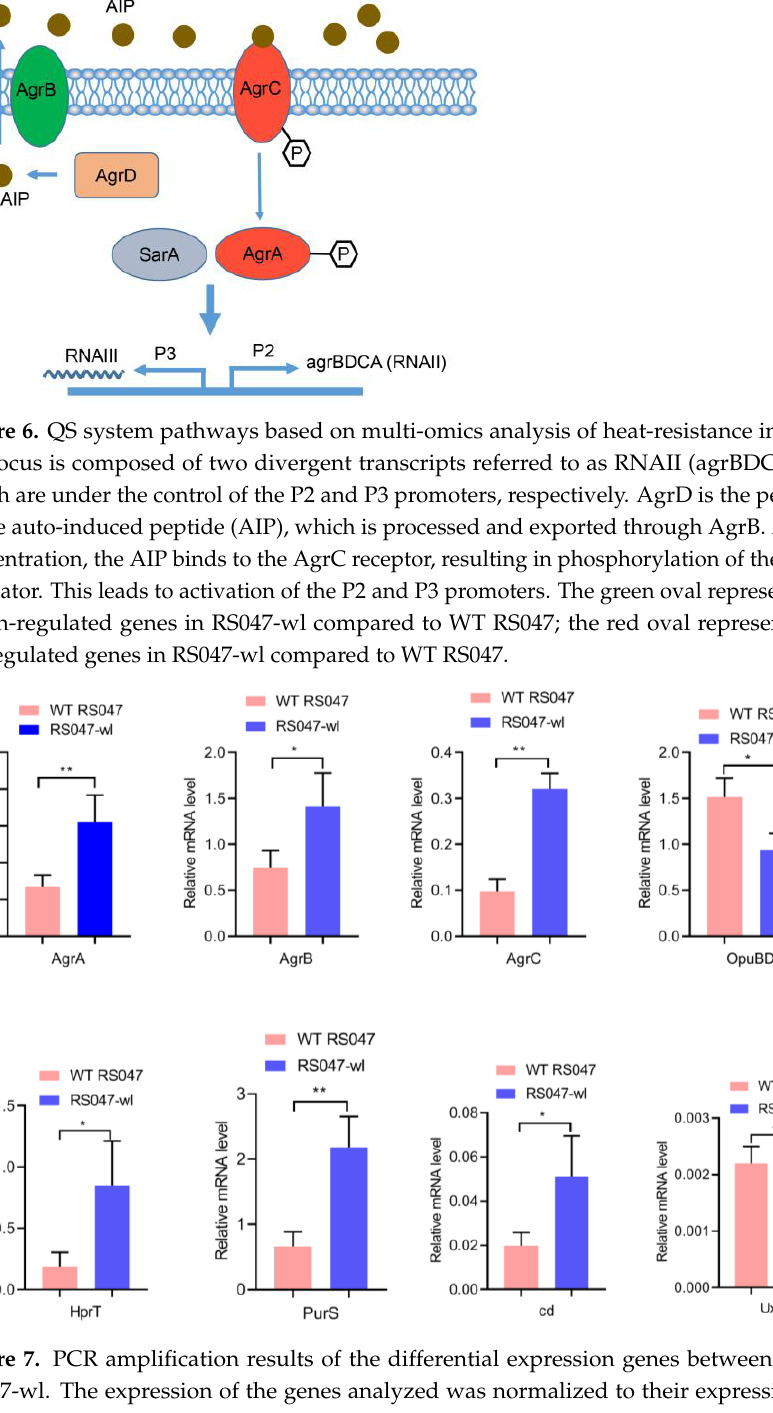
Figure 8. Membrane transport pathways based on multi-omics analysis of heat-resistance in RS047- wl. Colored rectangles are the relative content changes of metabolites in RS047-wl compared to WT RS047 (red, higher content; green, lower content; white, no significant change); ovals represent the